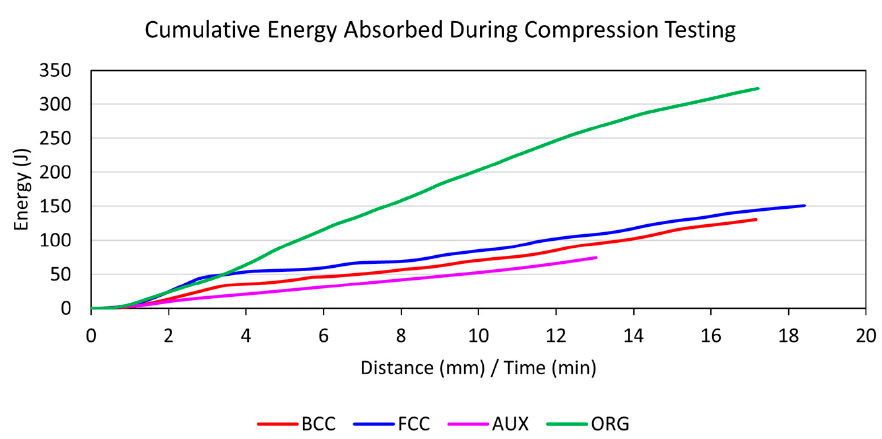
Figure 11. Cumulative energy absorbed during compression testing.